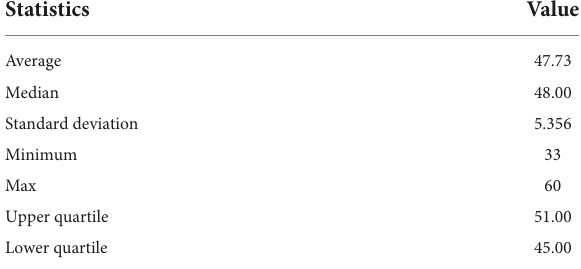
TABLE 3 Basic statistics for the recognition of in-service